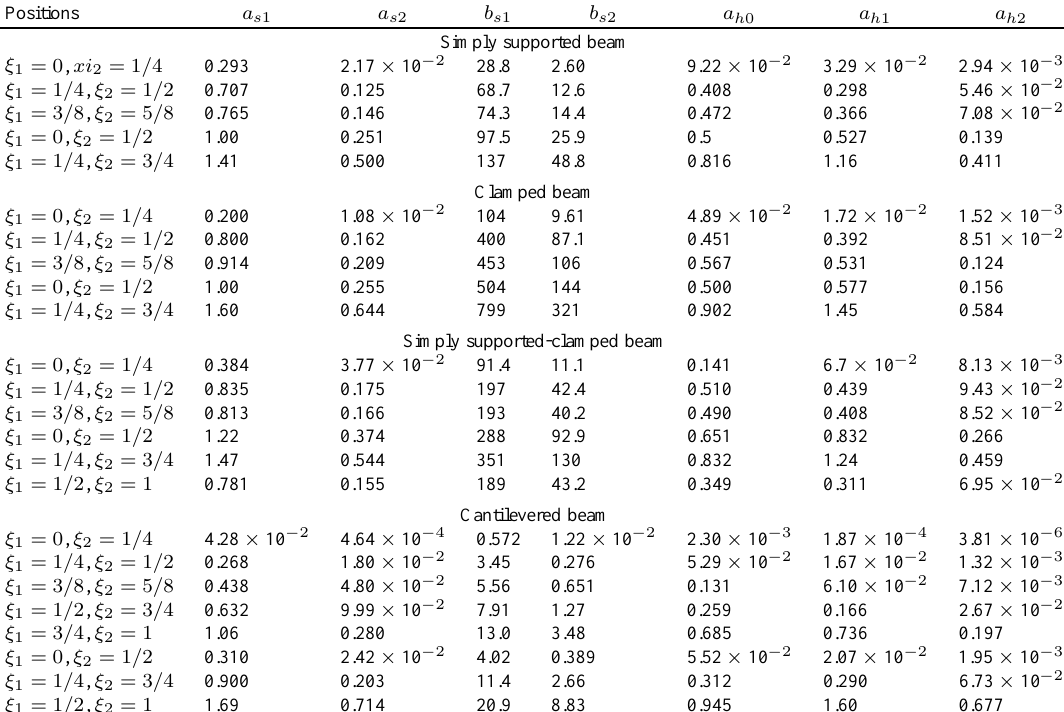
Table 3 The mass and stiffness factors of a beam with a uniformly distributed